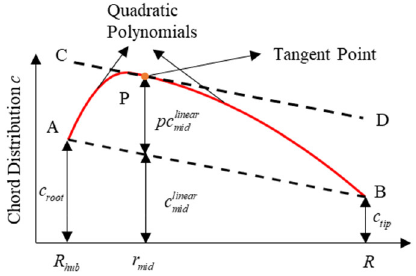
Figure 12. Piecewise quadratic polynomial parametric method for chord-length distribution.